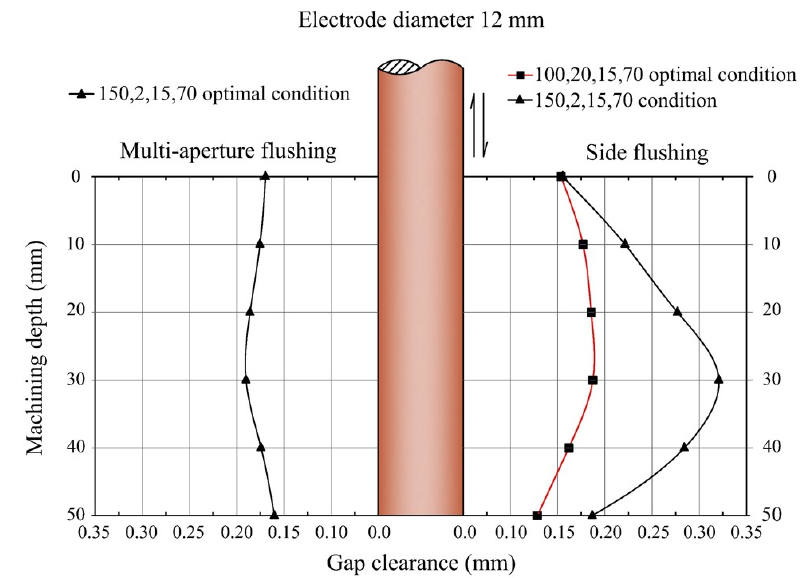
Figure 11. GC profiles of EDM with side flushing and multi-aperture flushing.